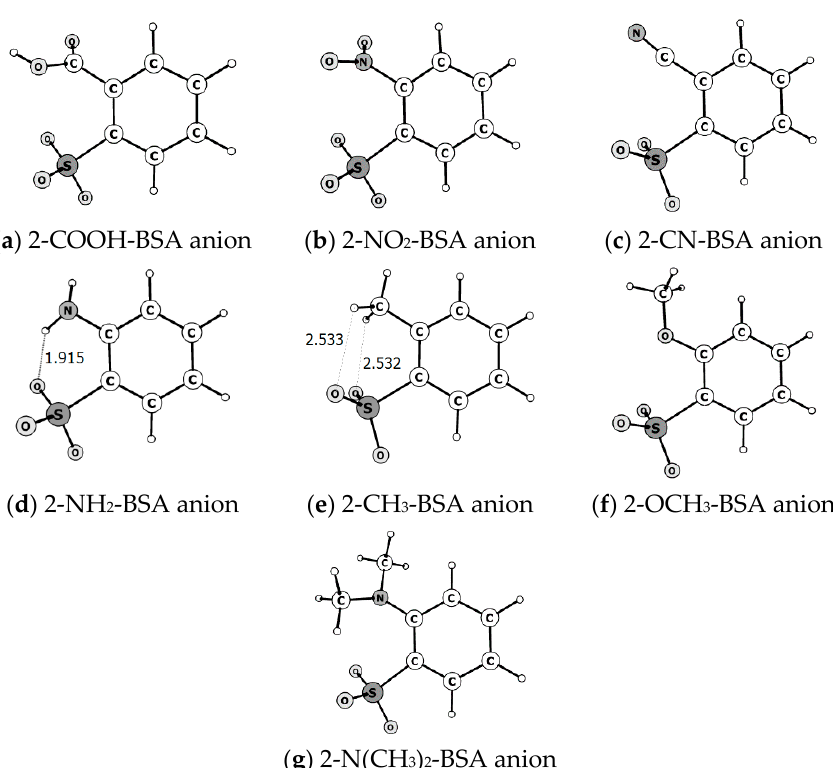
Figure 11. The structure of deprotonated forms of BSA (by sulfonic group), containing ortho